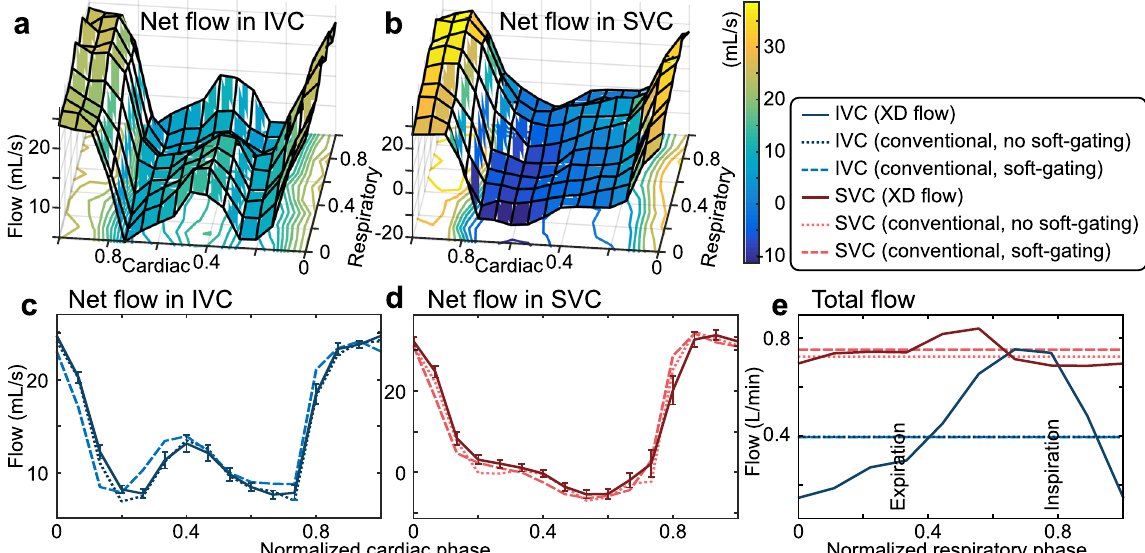
Figure 5. Ferumoxytol-enhanced XD flow reconstruction of a 3-year-old female highlighting the impact of respiration on flow analysis. The net flow through the inferior vena cava (IVC) and the superior vena cava (SVC) are plotted as a function of normalized cardiac and respiratory phase in ( a ) and ( b ). The average net flow across the different respiratory phases is plotted in ( c ) and ( d ) as a function of normalized cardiac phase. Blood flow measured in a conventional 4D flow reconstruction (with and without respiratory soft-gating) of the same dataset is also plotted in ( c ) and ( d ) as dotted and dashed lines. In ( e ), the total flow in the IVC and SVC is plotted as a function of normalized respiratory phase. The total flow is observed to be dependent on the respiratory phase. This feature is ignored in the conventional 4D flow reconstructions (dotted/dashed